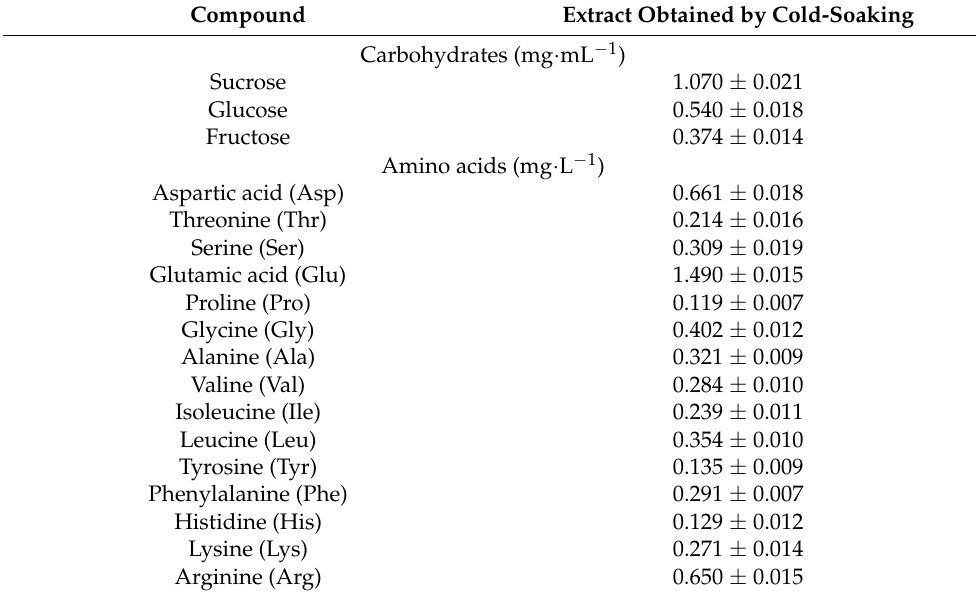
Table 2. Carbohydrates and amino acids in water extract from L. usitatissimum (average ±